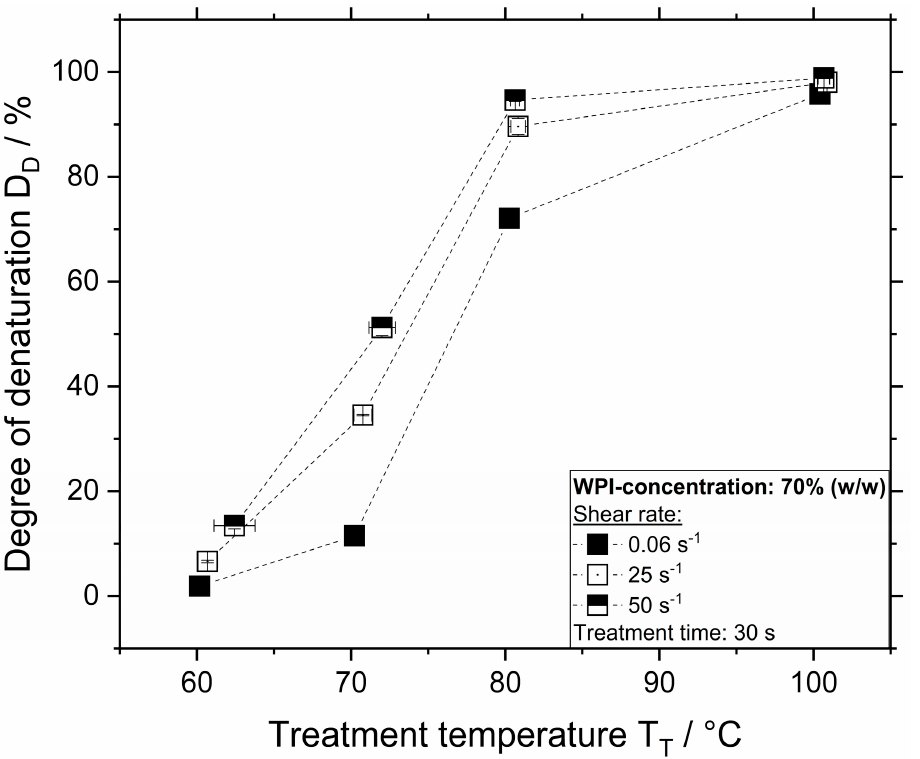
Figure 4. Degree of denaturation as a function of temperature and shear rate for a WPI concentration of 70% ( w / w ) and treatment time of 30 s.